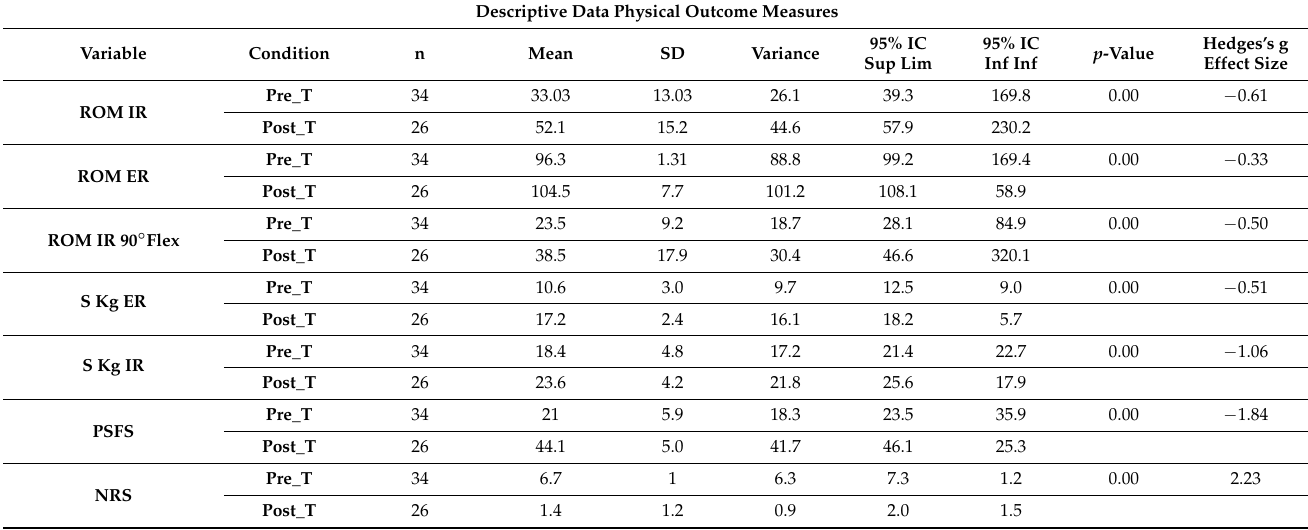
Figure 2. EMG onset time (ms) of activation (median ± IQR) during Scaption prior and after standardized physiotherapy treatment for SIS. Descriptive data: Median, IQR (Inter Quartile Range) of onset time of activation during flexion movement at different load and speed. UL (Unloaded), L (Loaded), Slow (slow speed), Mid (medium speed) Fast (fast speed). Muscles; UT (Upper Trapezius), AD (Anterior Deltoid), MD (Mid Deltoid), PD (Posterior Deltoid), LT (Lower Trapezius), SA (Serratus Anterior), Pec (Pectoralis Major), Susbc (Subscapularis), SS (Supraspinatus), IF (infraspinatus). Table 5. Descriptive statistics of clinical features of ROM, strength, pain and